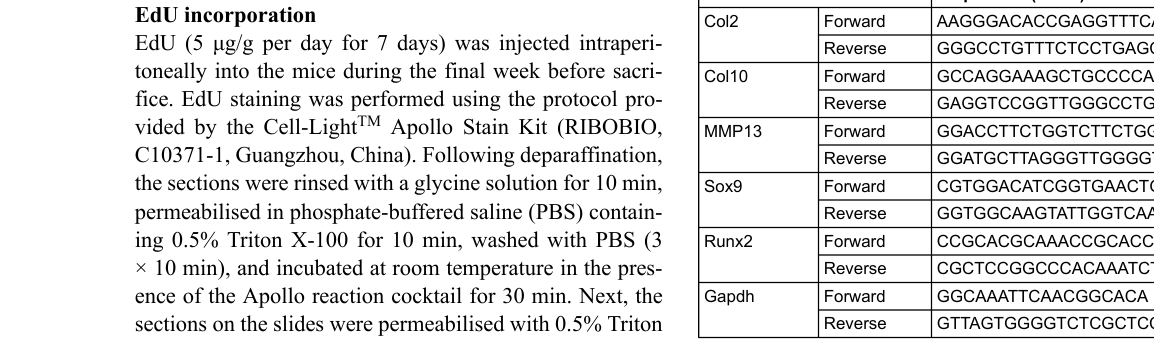
Table 1: Sequences of the primers used in this study.